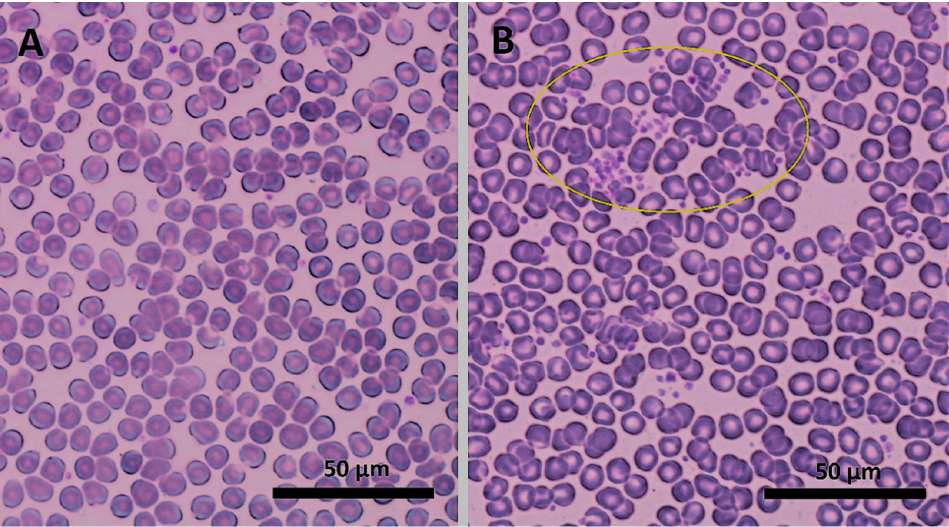
Figure 1. Images of blood smears before ( A ) and after ( B ) adding and incubation of the second- generation dendron D2 at a concentration of 10 µ M (C2) from light microscopy at 100 × magnification. The small purple particles represent platelets, which under these experimental conditions created clumps (yellow ellipse).